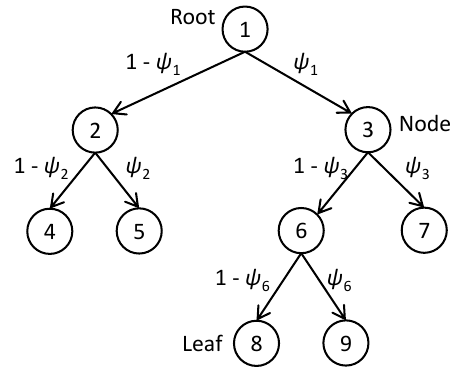
Figure 2. Hierarchical model structure with 5 local models (at